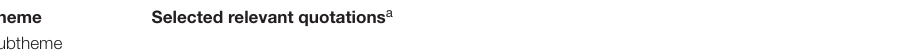
TABLE 2 | Changes in children’s daily routines during the pandemic impacted their sugary drink, snack, and meal intake. Theme Selected relevant quotations a Subtheme Theme 1: Increases in SD consumption due to being at home Access to